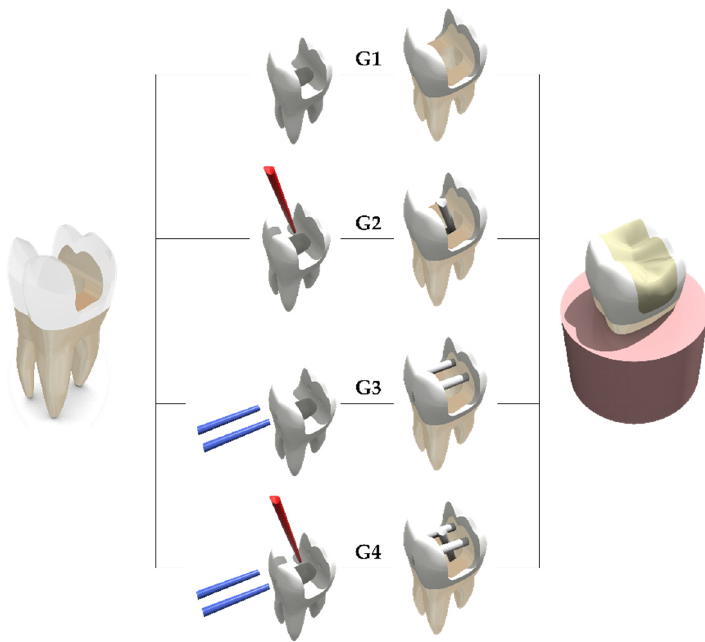
Figure 1. Three-dimensional models created in the modeling software with different post-endodontic restorative treatments: ( G1 ) no-post approach; ( G2 ) glass fiber cemented in the palatal root canal; ( G3 ) two transfixed glass fiber posts; and ( G4 ) two transfixed glass fiber posts and one glass fiber post in the palatal root canal. In red the conventional glass fiber post and in blue the transfixed glass fiber posts.